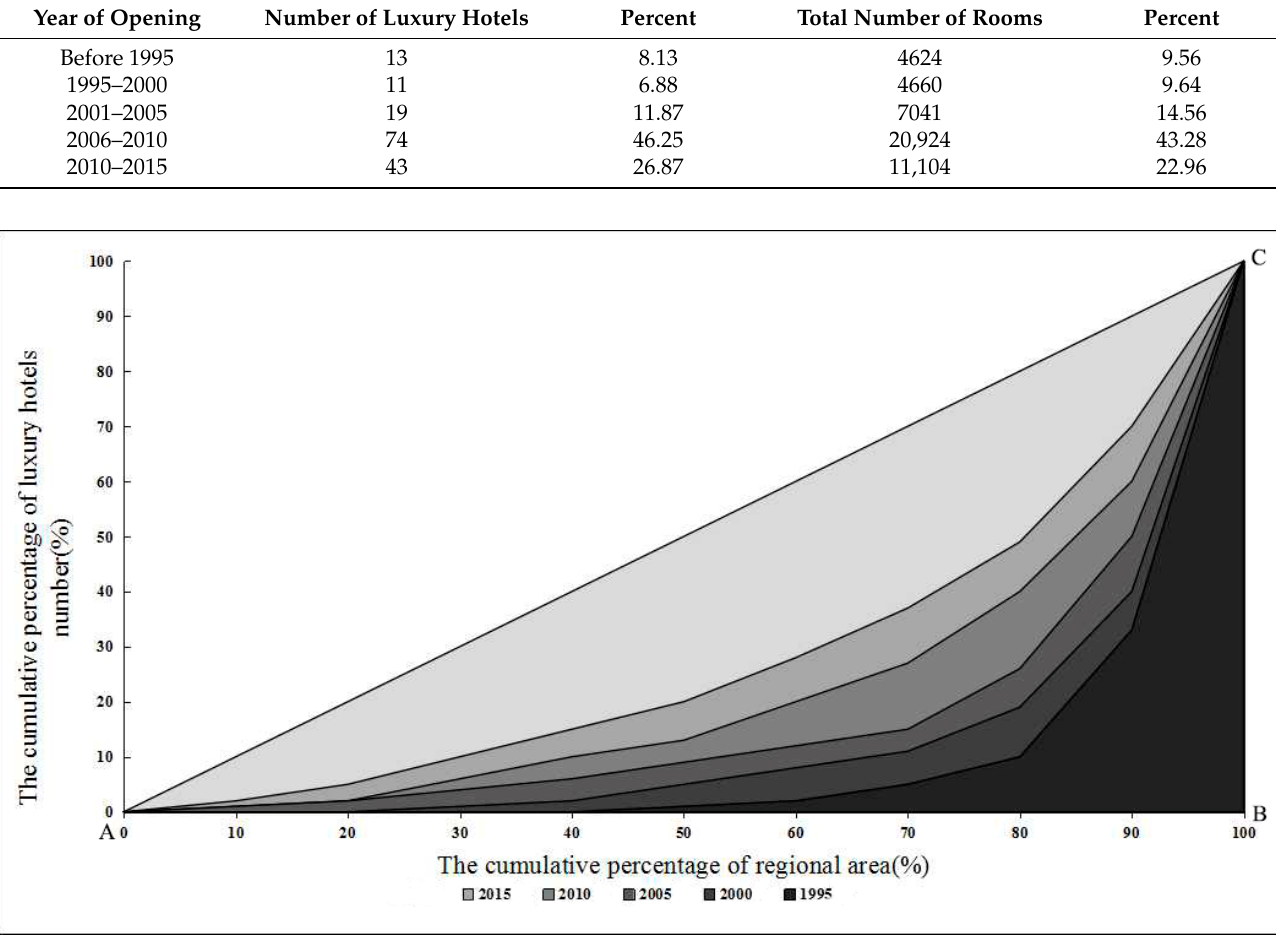
Figure 3. Lorenz curve of luxury hotel distribution in Shanghai City.